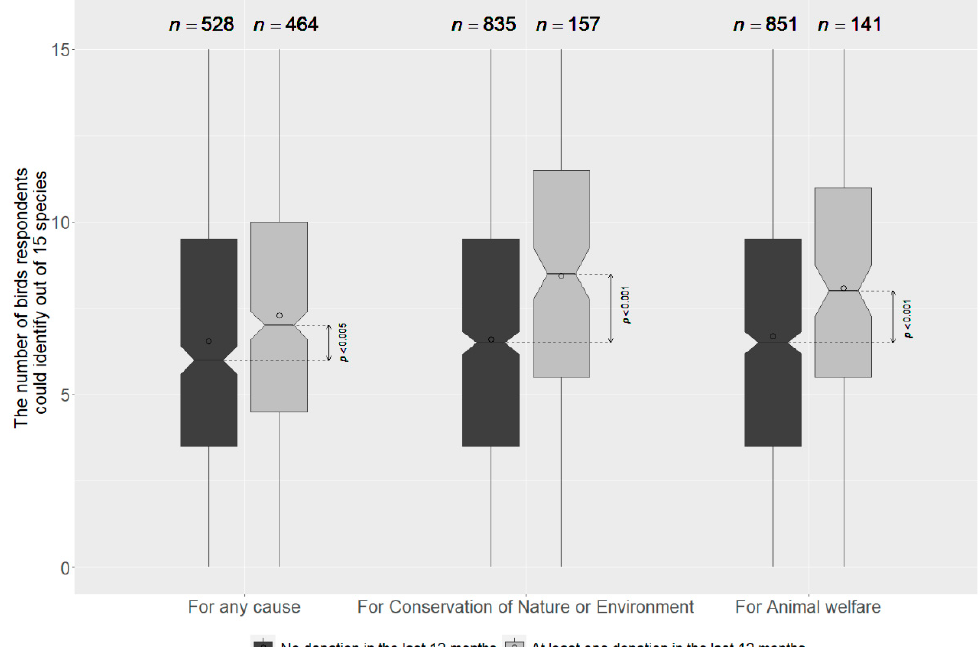
Figure 3. Bird species knowledge of donors (grey) compared with non-donors (black) with signifi- cance level p and the number of participants in the group n. Lower end of the boxplot shows the first quartile, the median is indicated by a line in the notch (95% confidence interval of the median) and the 75% quartile is marked by the upper end of the boxplot. The dot within the boxplot indicates the mean value of the score.